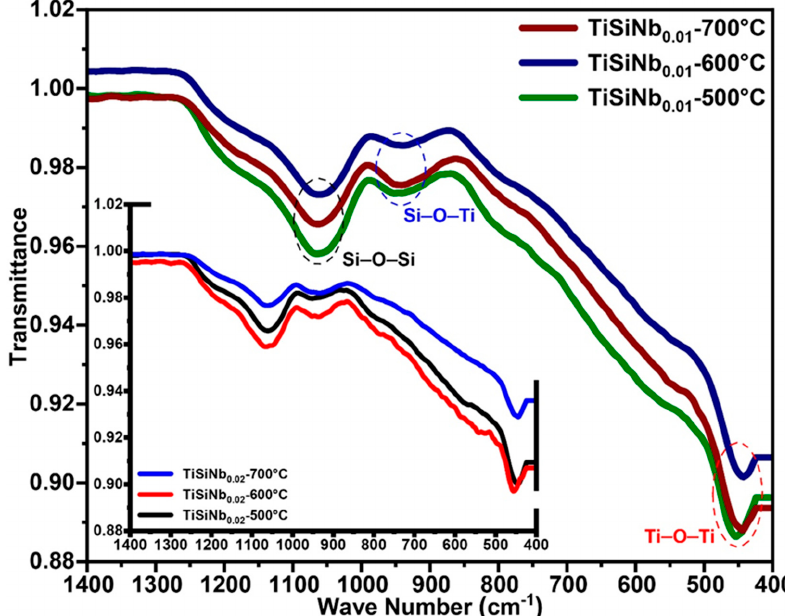
ff erent temperatures and